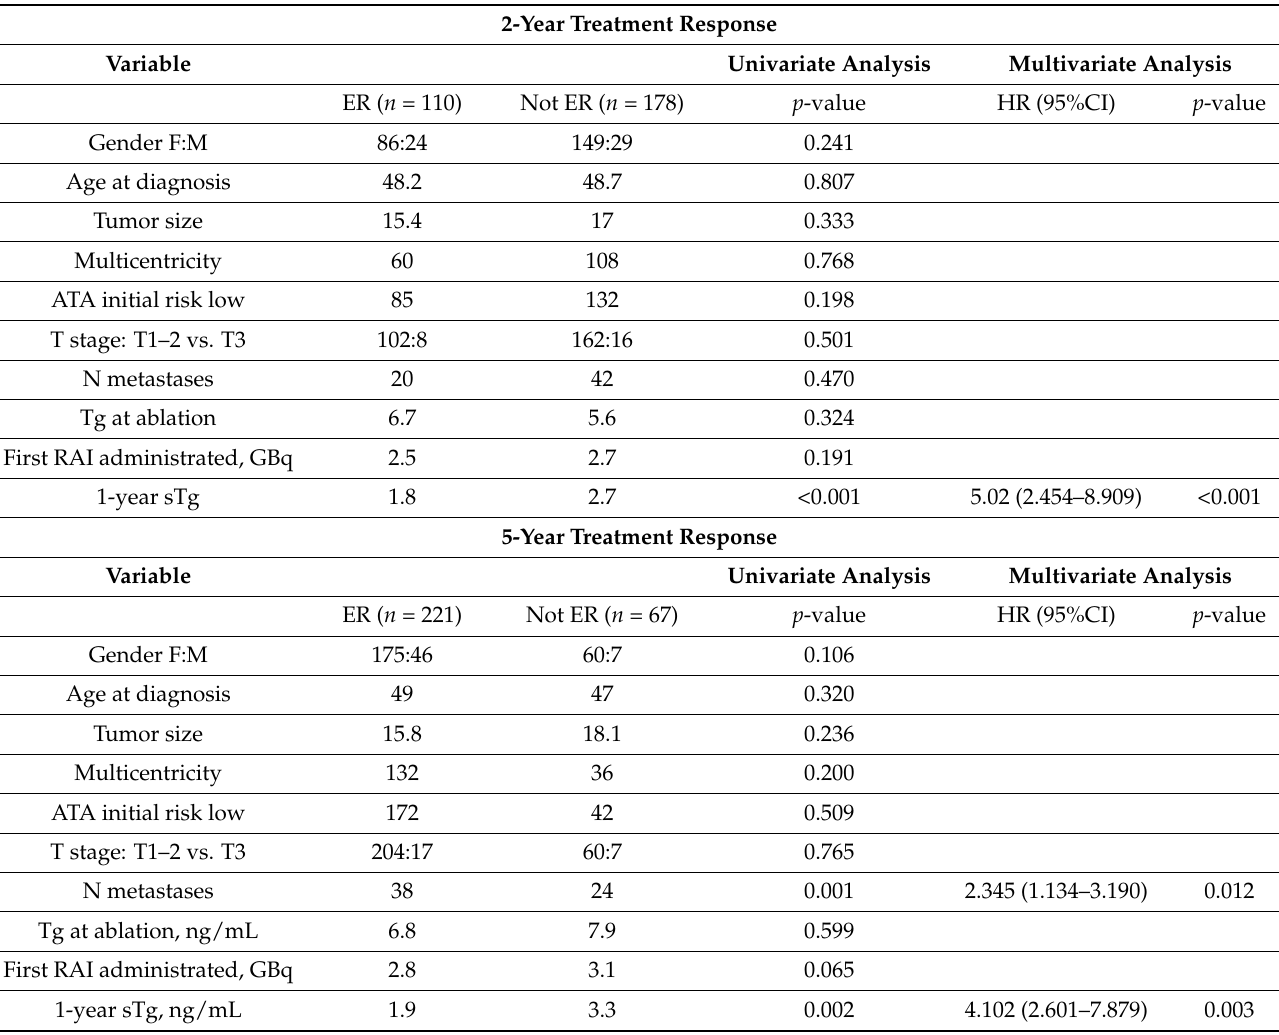
Table 2. Univariate and multivariate analysis of factors associated with final disease